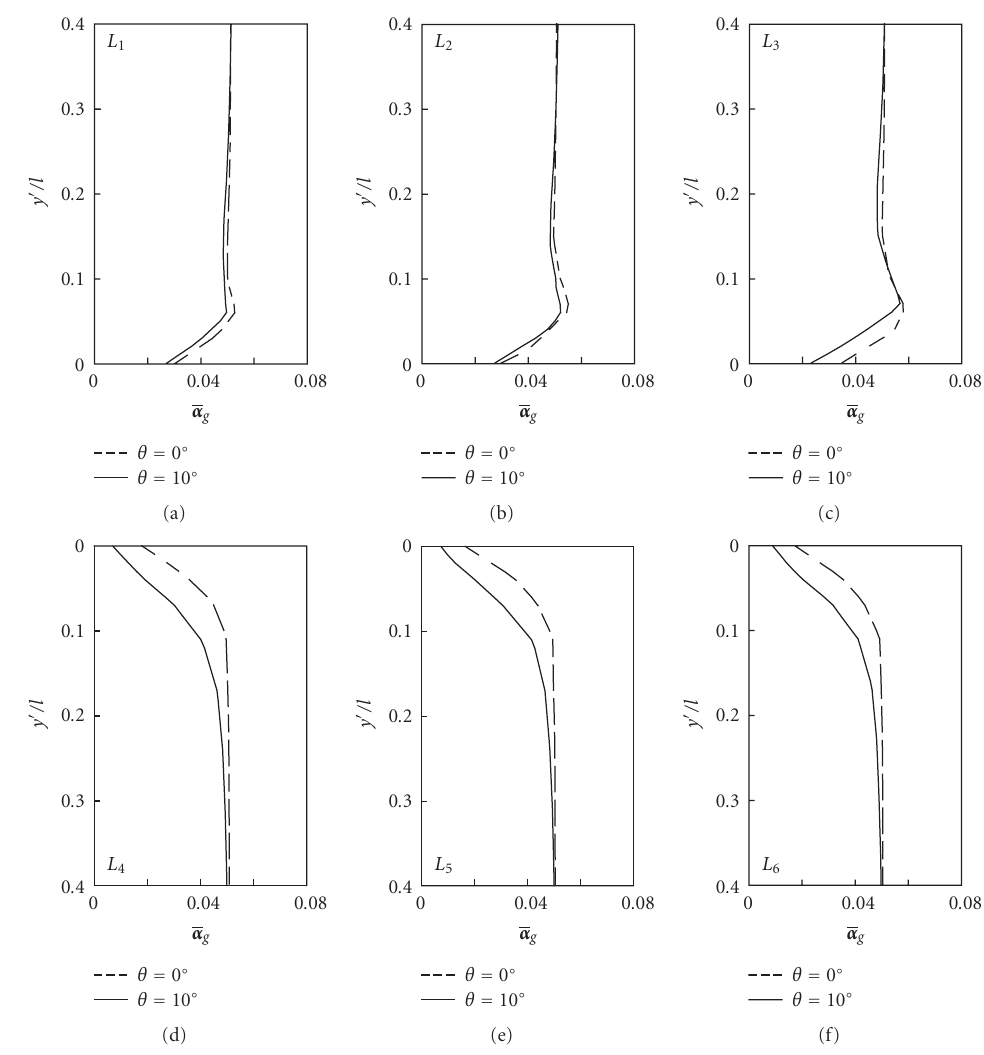
Figure 8: Time-averaged air volume fraction around